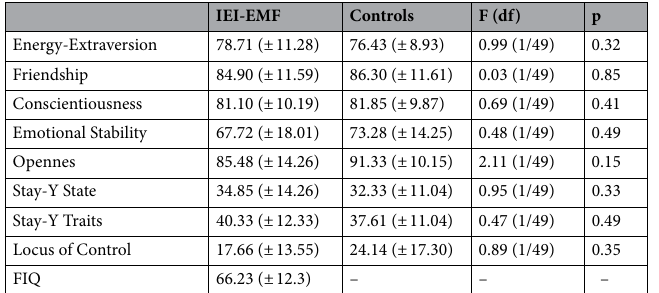
Table 1. Psychological variables and FIQ (Fibromyalgia Impact Questionnaire) (means and standard